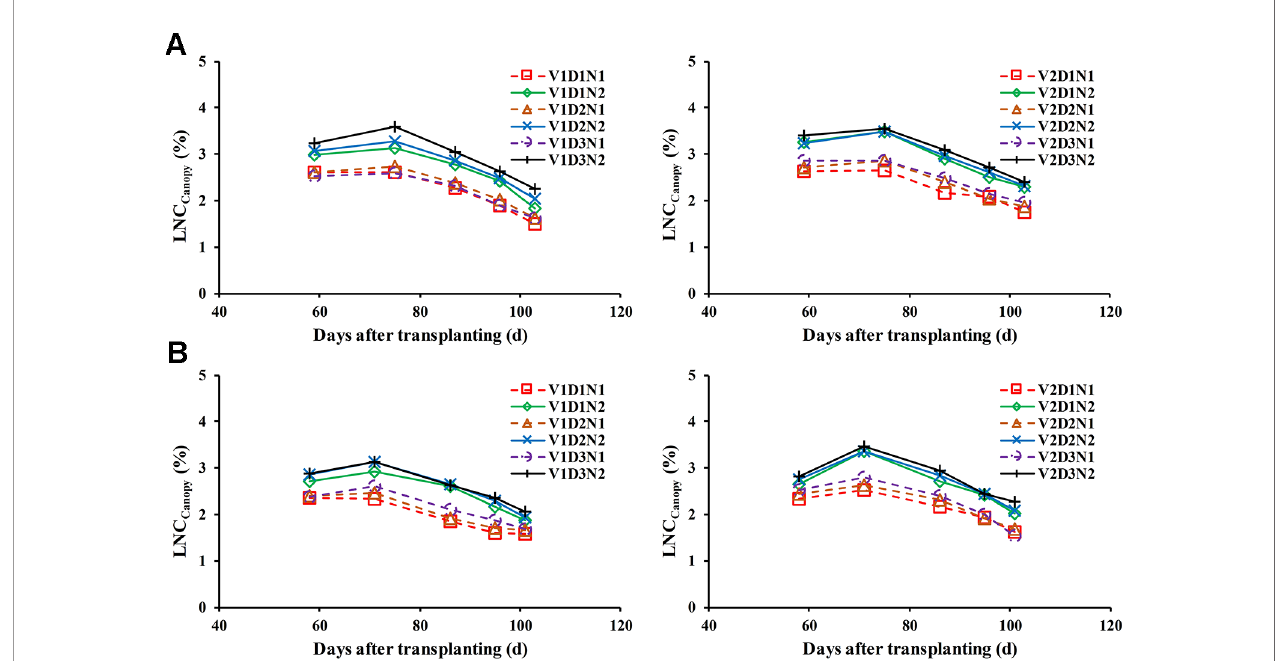
FIGURE 2 | Changes of the LNC Canopy during the whole growth stages under different treatment in 2015 (A) and 2016 (B) . Jointing fertilizer was applied at approximately 60 days after transplanting (DAT).